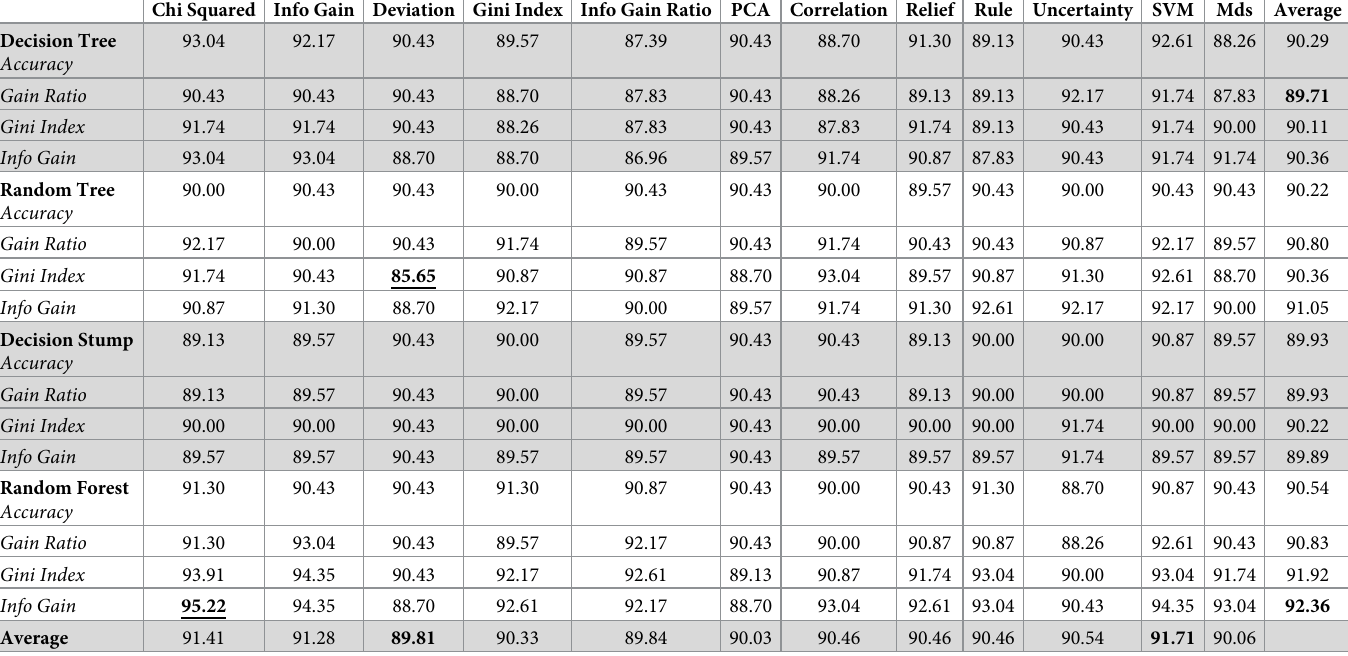
Table 3. The accuracy of four different tree induction models (each with four criteria, Accuracy, Gain Ratio, Gini Index and Information Gain) on twelve datasets computed by10-foldcross validation. Chi Squared Info Gain Deviation Gini Index Info Gain Ratio PCA Correlation Relief Rule Uncertainty SVM Mds Average Decision